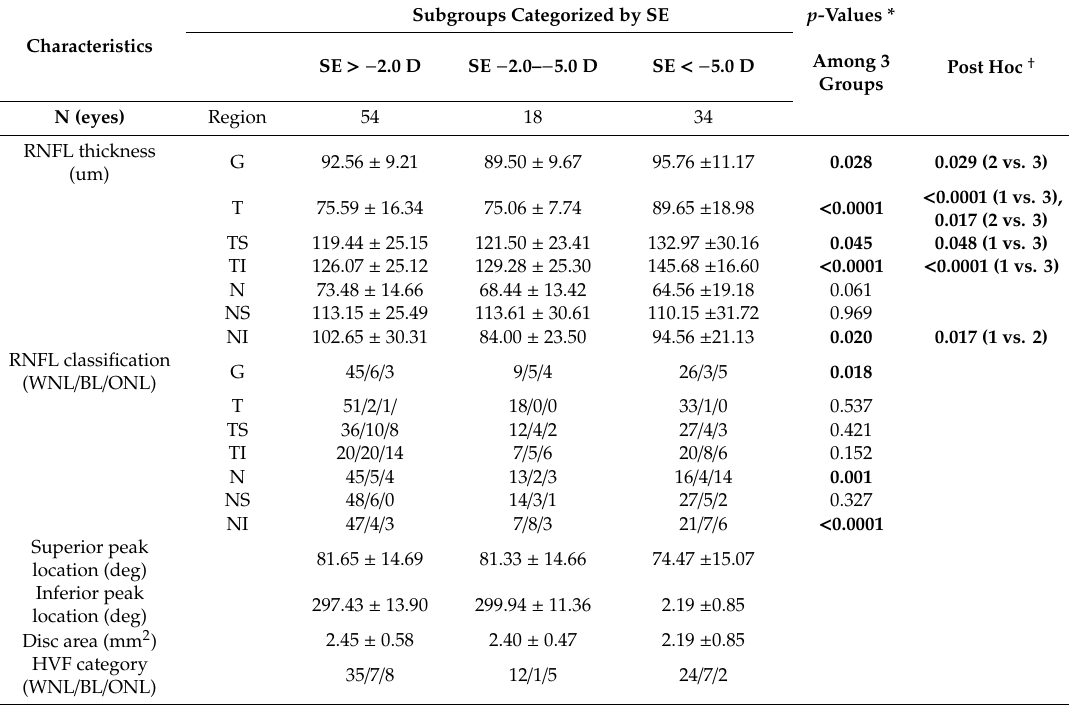
Table 5. Retinal nerve fiber layer according to